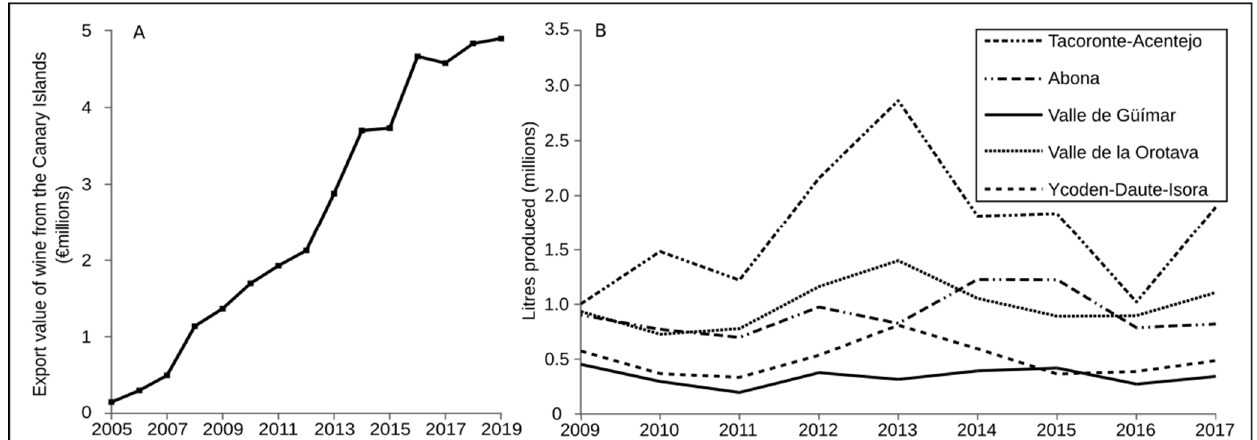
Figure 1. ( A ) The rise in revenue generated by the export of wine from the Canary Islands [33]. ( B ) Reported wine production figures for the Tenerife Denominación de Origens [34].